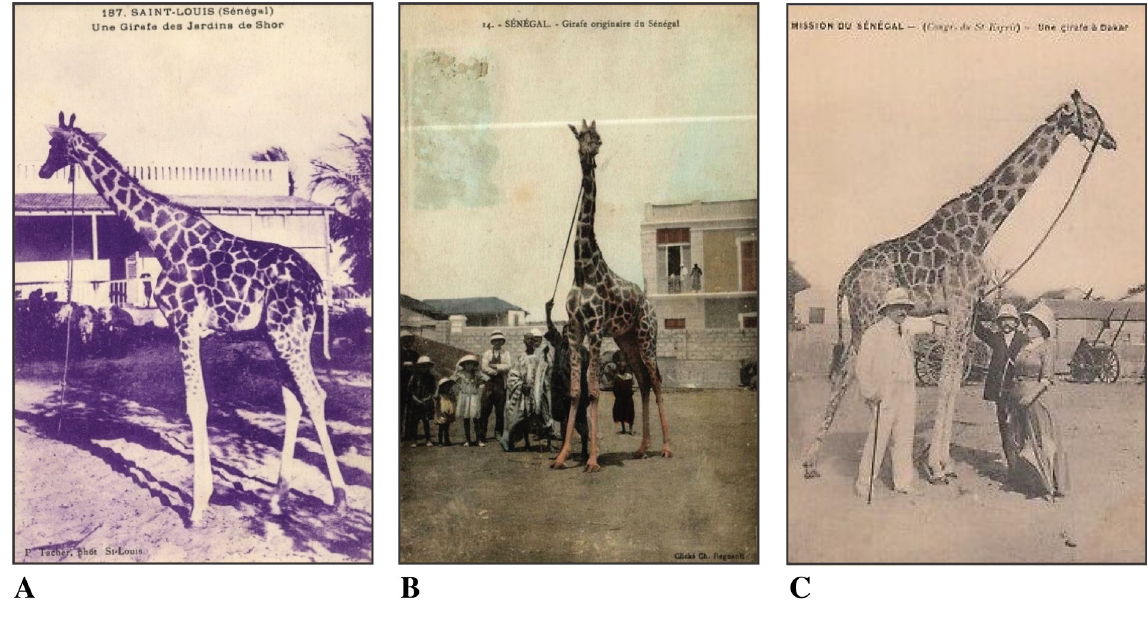
Fig. 6. Postcards of the Senegal giraffe at the beginning of the 20 th century. A . “Une Girafe des Jardins de Shor”, photo taken by P. Tacher in 1909 ( https://oldthing.ch/AK-Saint-Louis-Une-Girafe-des-Jardins- de-Shor-Giraffe-im-Gehege-0033371252 ). B . “Girafe originaire du Sénégal” ( https://www.ebay.fr/sch/ Cartes-postales/914/i.html?cmd=Blend%7CBlend&_nkw=girafe ). C . “Mission du Sénégal –